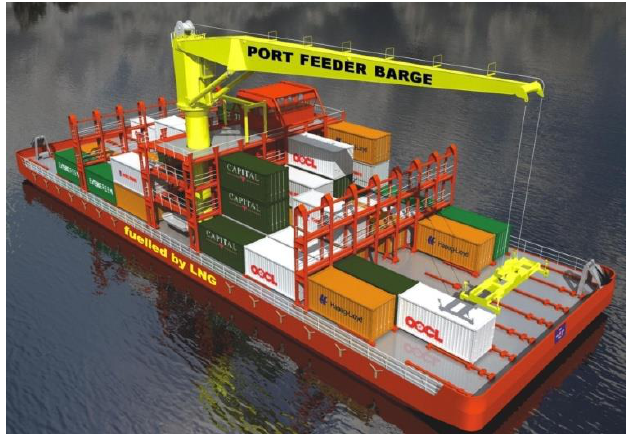
Figure 5: Port Feeder Barge (computer rendering)